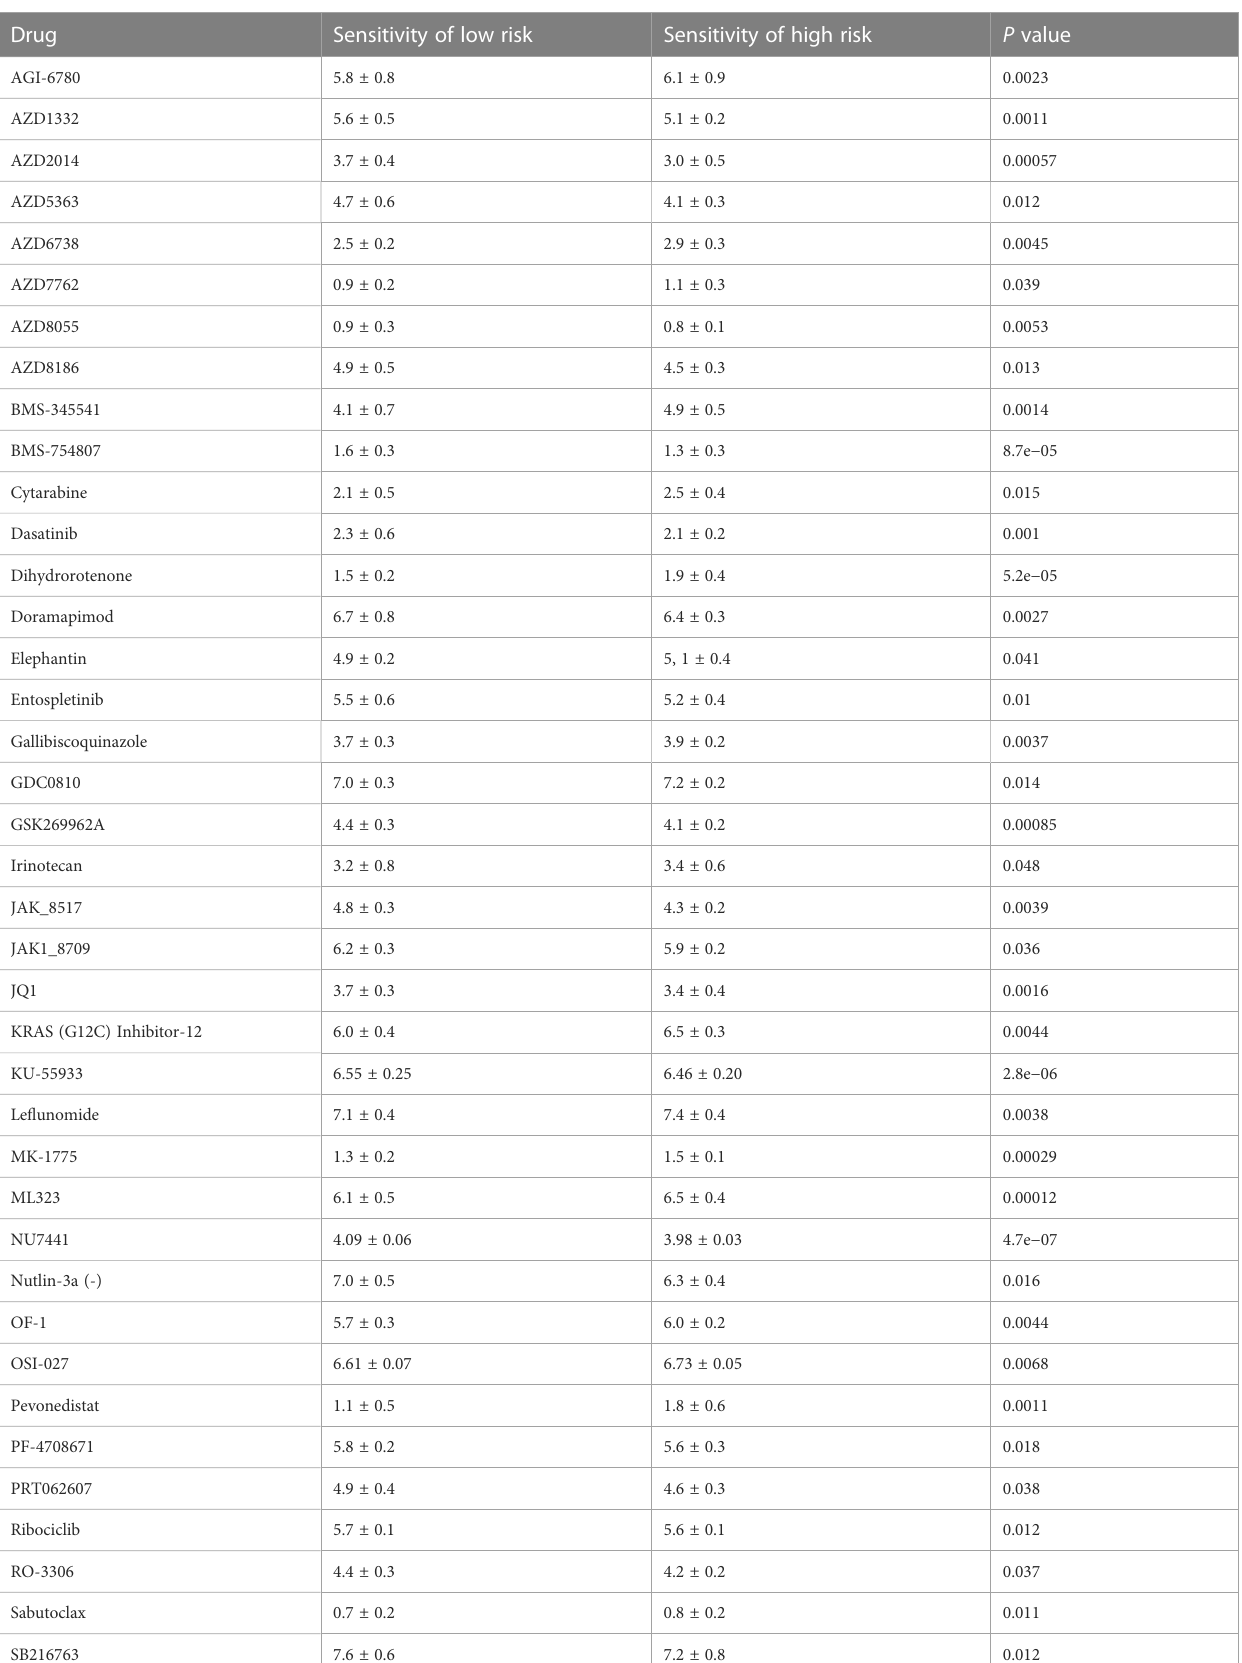
TABLE 3 Immunotherapy drug sensitivity and expression differences in different